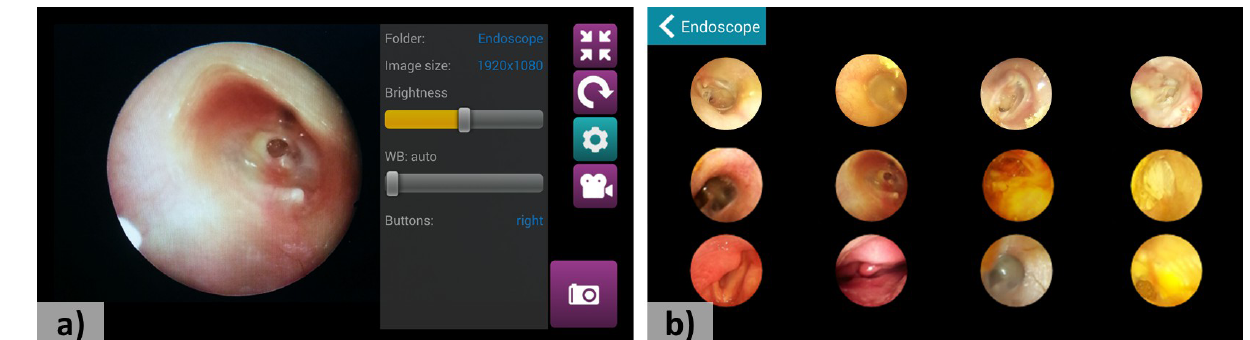
Figure 3. Android based software for the smartphone-based endoscope system. (a) Main capturing screen. (b) Gallery mode of the